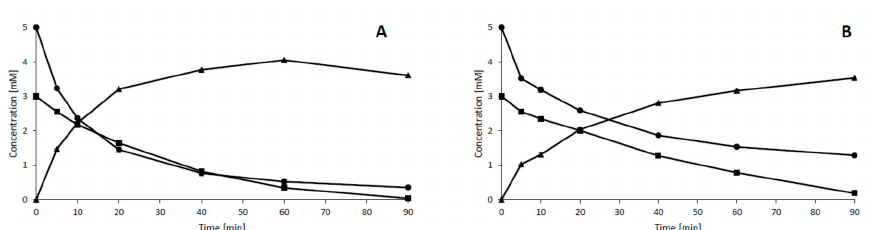
Figure 1. Tyrosinase-catalyzed reactions of 1a (5 mM) using ( A ) commercial tyrosinase or ( B ) crude tyrosinase with 30 mM L -ascorbic acid sodium salt (AASS). The concentrations (mM) of phenol 1a ( • ), catechol 1b ( ▲ ) and AASS (0.1 × concentration; ) were determined by HPLC. See Materials and Methods for details.